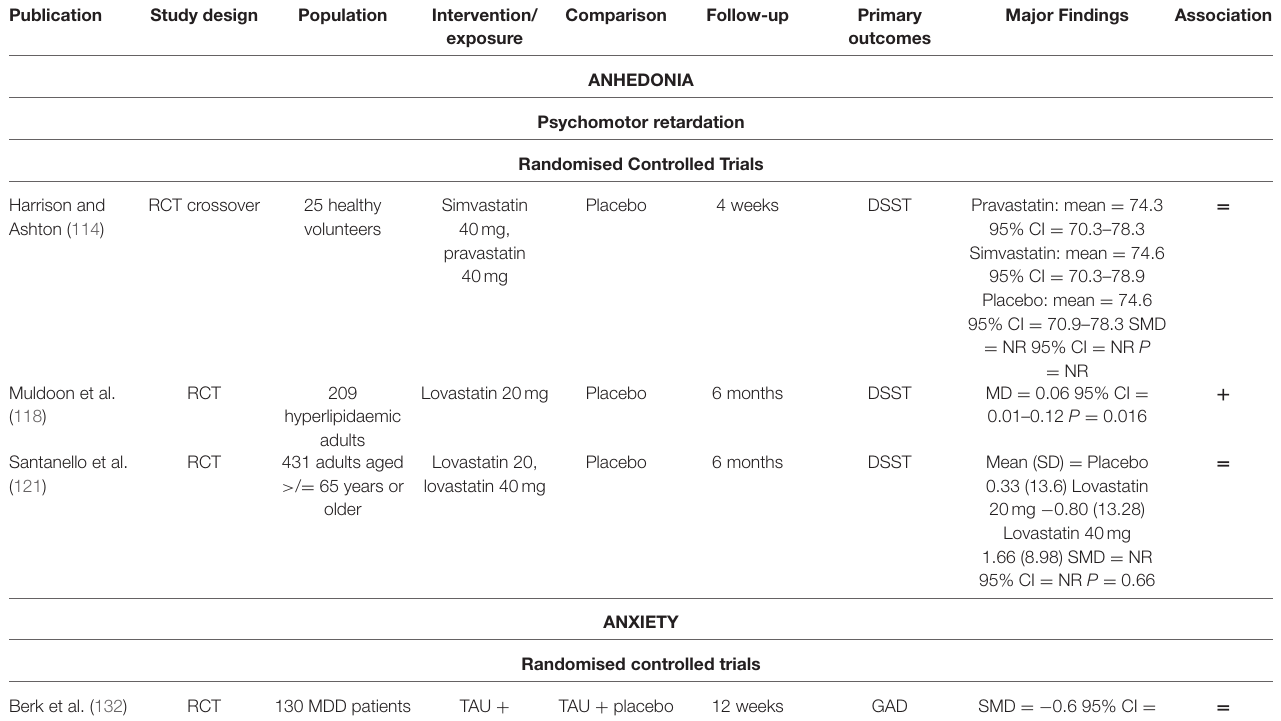
TABLE 4 | Overview of studies regarding the effects of statins on depressive-inflammatory